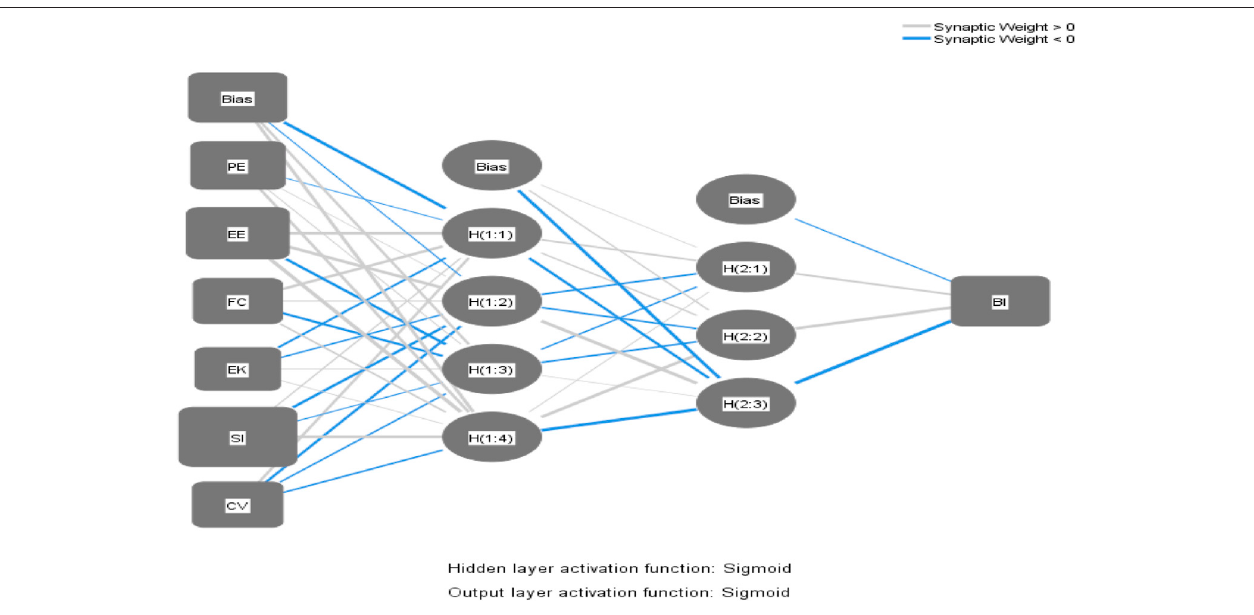
FIGURE 6 | ANN model for BI.